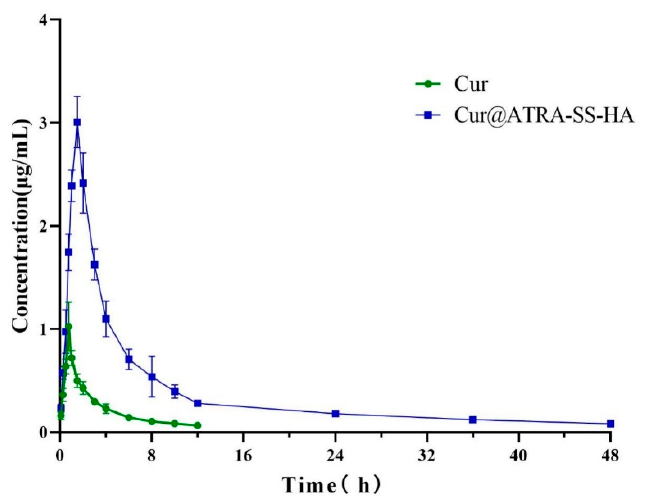
Figure 6. Plasma curcumin concentration at different time points within 48 h after injection of free curcumin and Cur@ATRA-SS-HA.